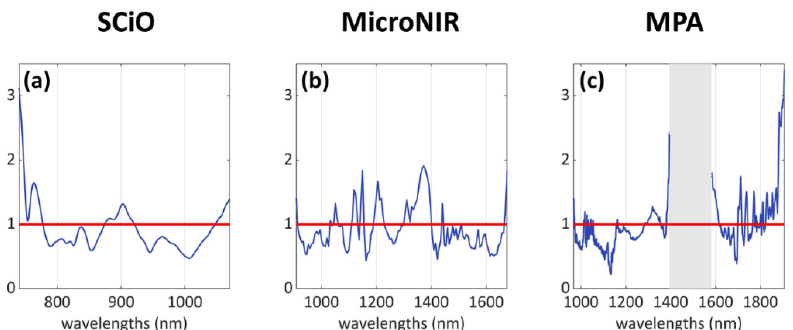
Figure 4. Variable importance in projection (VIP) scores of the three PLS-DA classification models: ( a ) SCiO results, ( b ) MicroNIR results, and ( c ) MPA results. The traditional VIP threshold = 1 is represented in red.